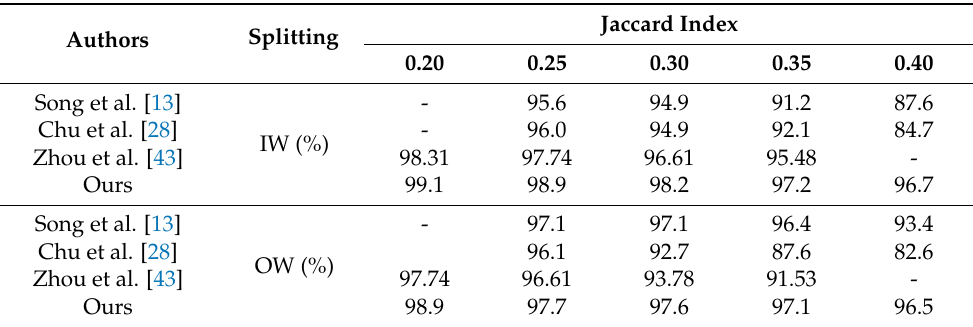
Table 3. Grasp detection accuracy on Cornell dataset with different Jaccard